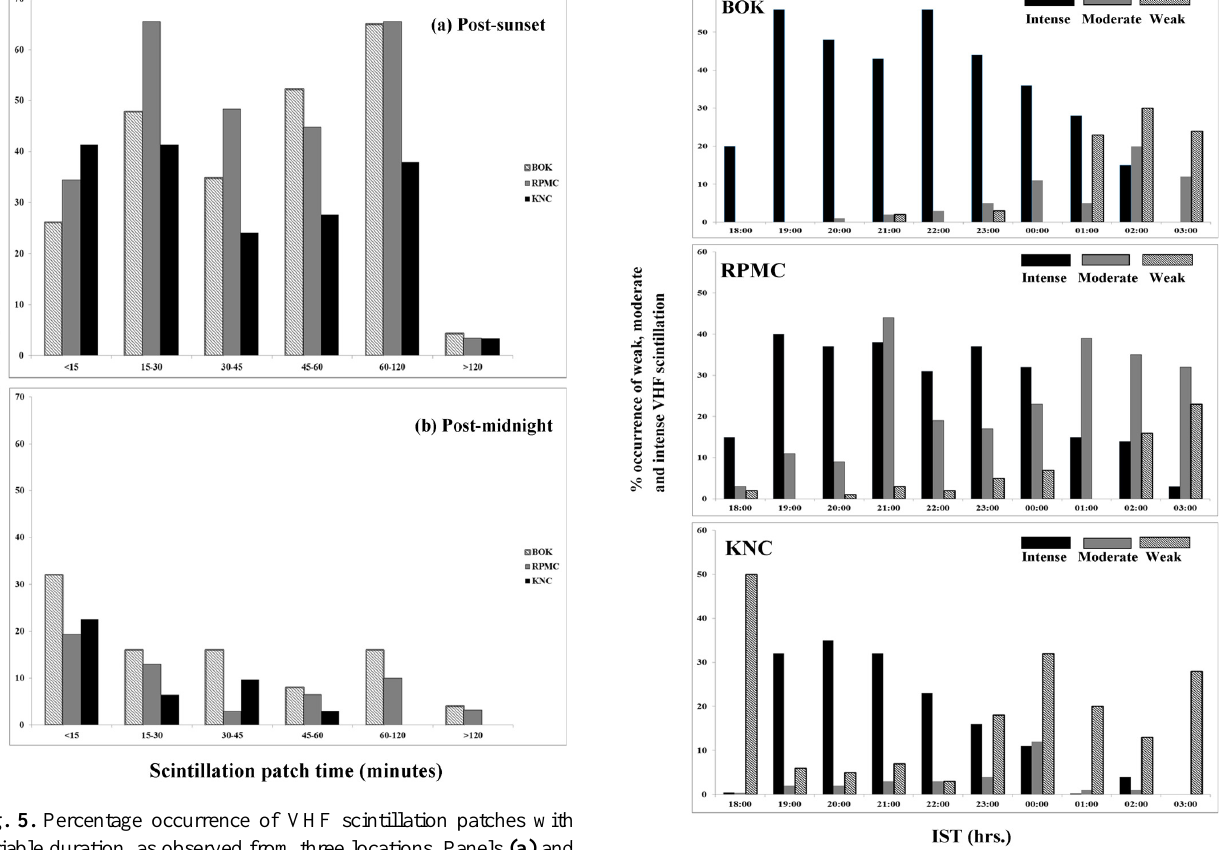
Fig. 6. Bar diagrams showing hourly variation of S 4 index for weak ( S 4 ≈ 0 . 2–0.4), moderate ( S 4 ≈ 0 . 4–0.8) and intense ( S 4 > 0 . 8) scintillations at BOK, RPMC and KNC during the period of ob-